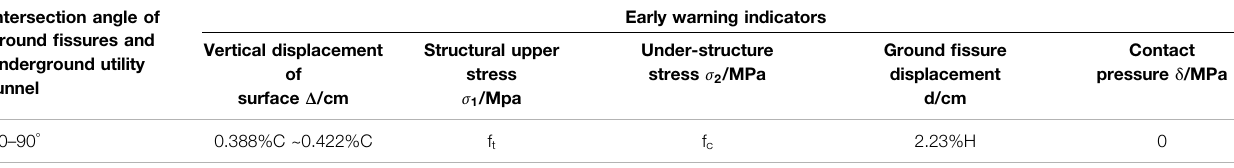
TABLE 4 | Early warning control value. Intersection angle of ground fi ssures and underground utility